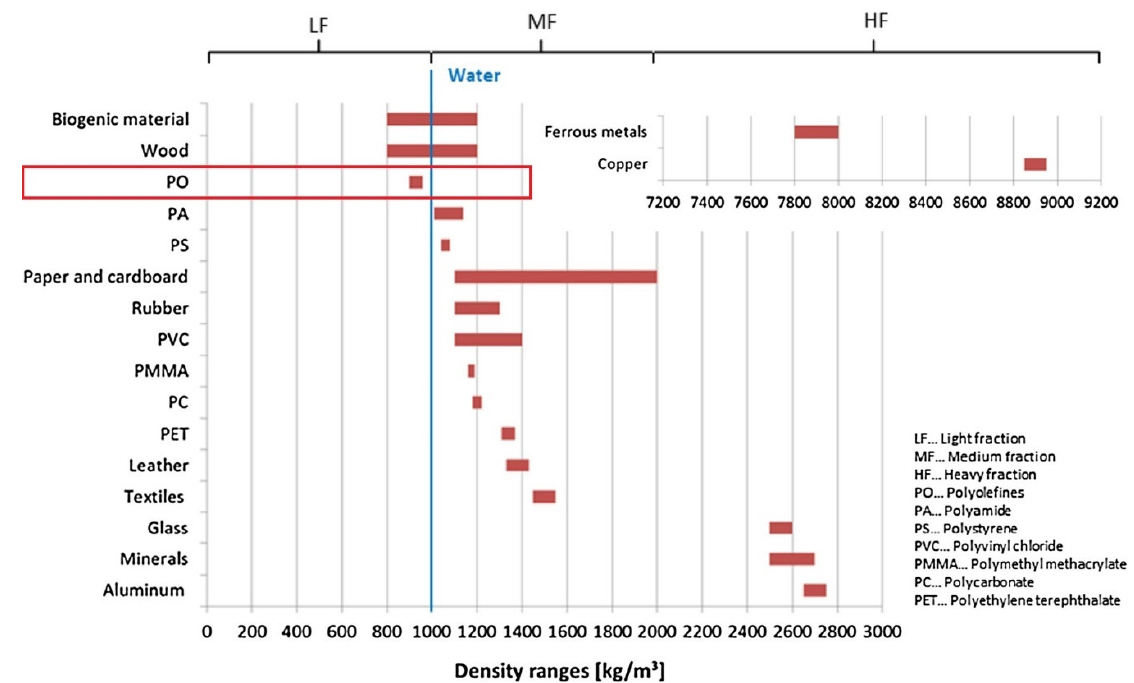
Figure 2. Density ranges of common components of mixed waste fractions and their respective product of the separation process [14].